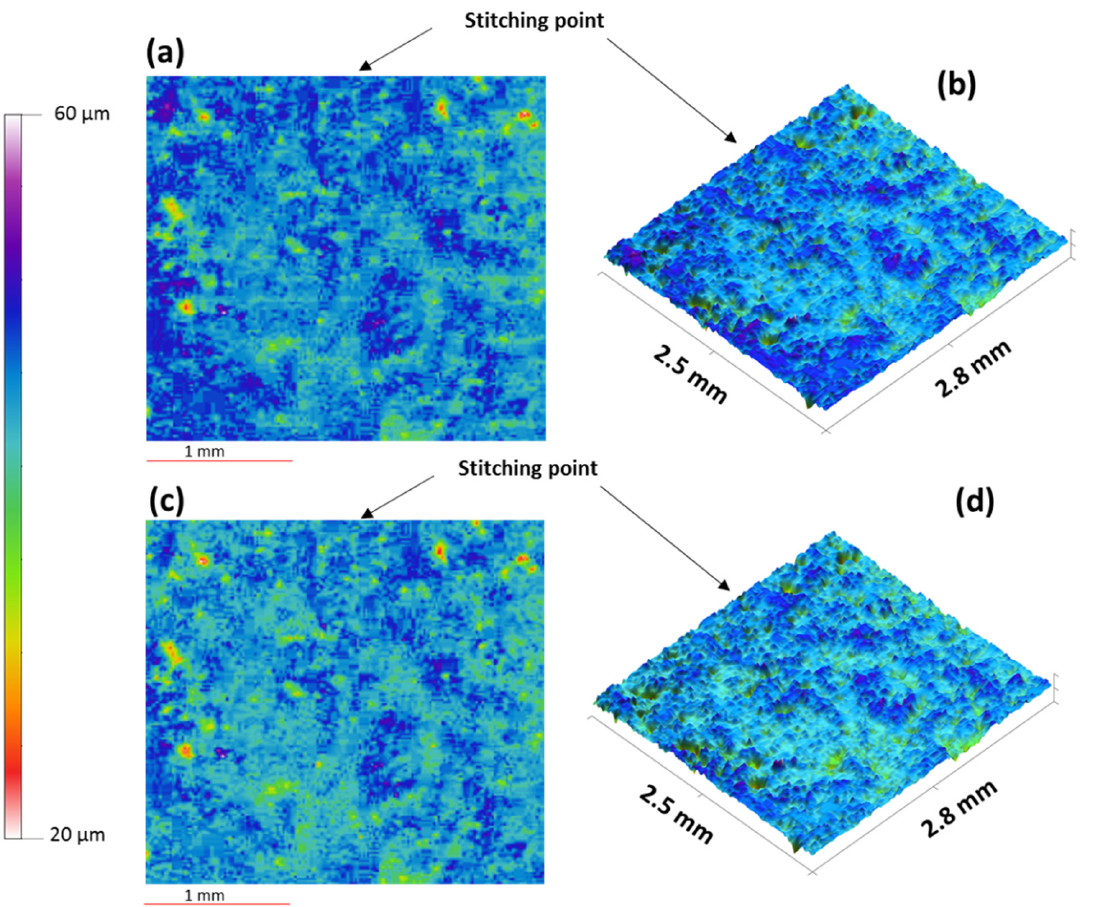
Figure 6. ( a ) 2D and ( b ) 3D surface texture images produced using optical profilometry, ( c ) 2D and, ( d ) 3D surface texture images produced using the newly developed ETL-based variable focus imaging system showing the zoomed area and the image-stitching points.